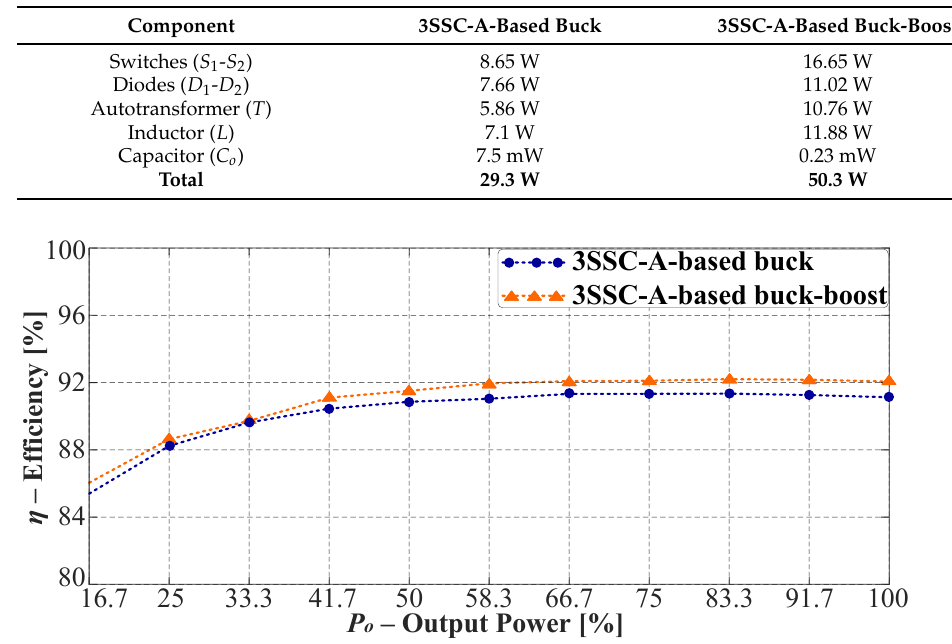
Figure 13. Power loss estimation at full load in percentage: ( a ) 3SSC-A-based buck; ( b ) 3SSC-A-based buck-boost. Table 7. Power losses per component.